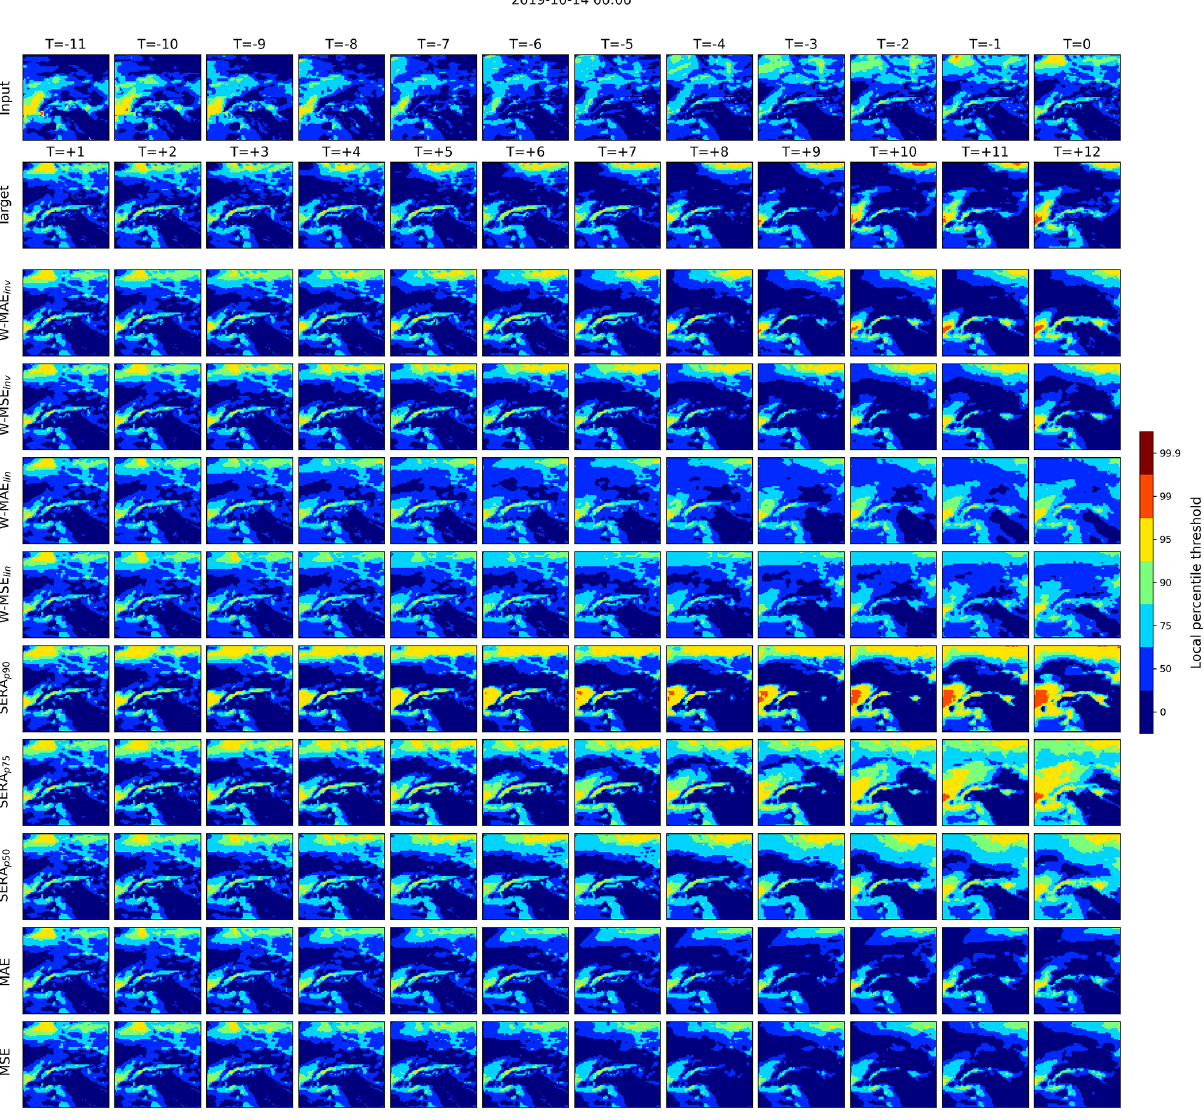
Figure 11. As Fig.